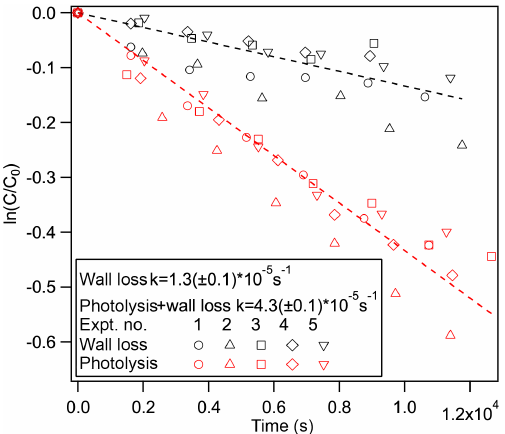
Figure 6. Wall loss and photolysis loss of the nitrooxy enal in the reaction